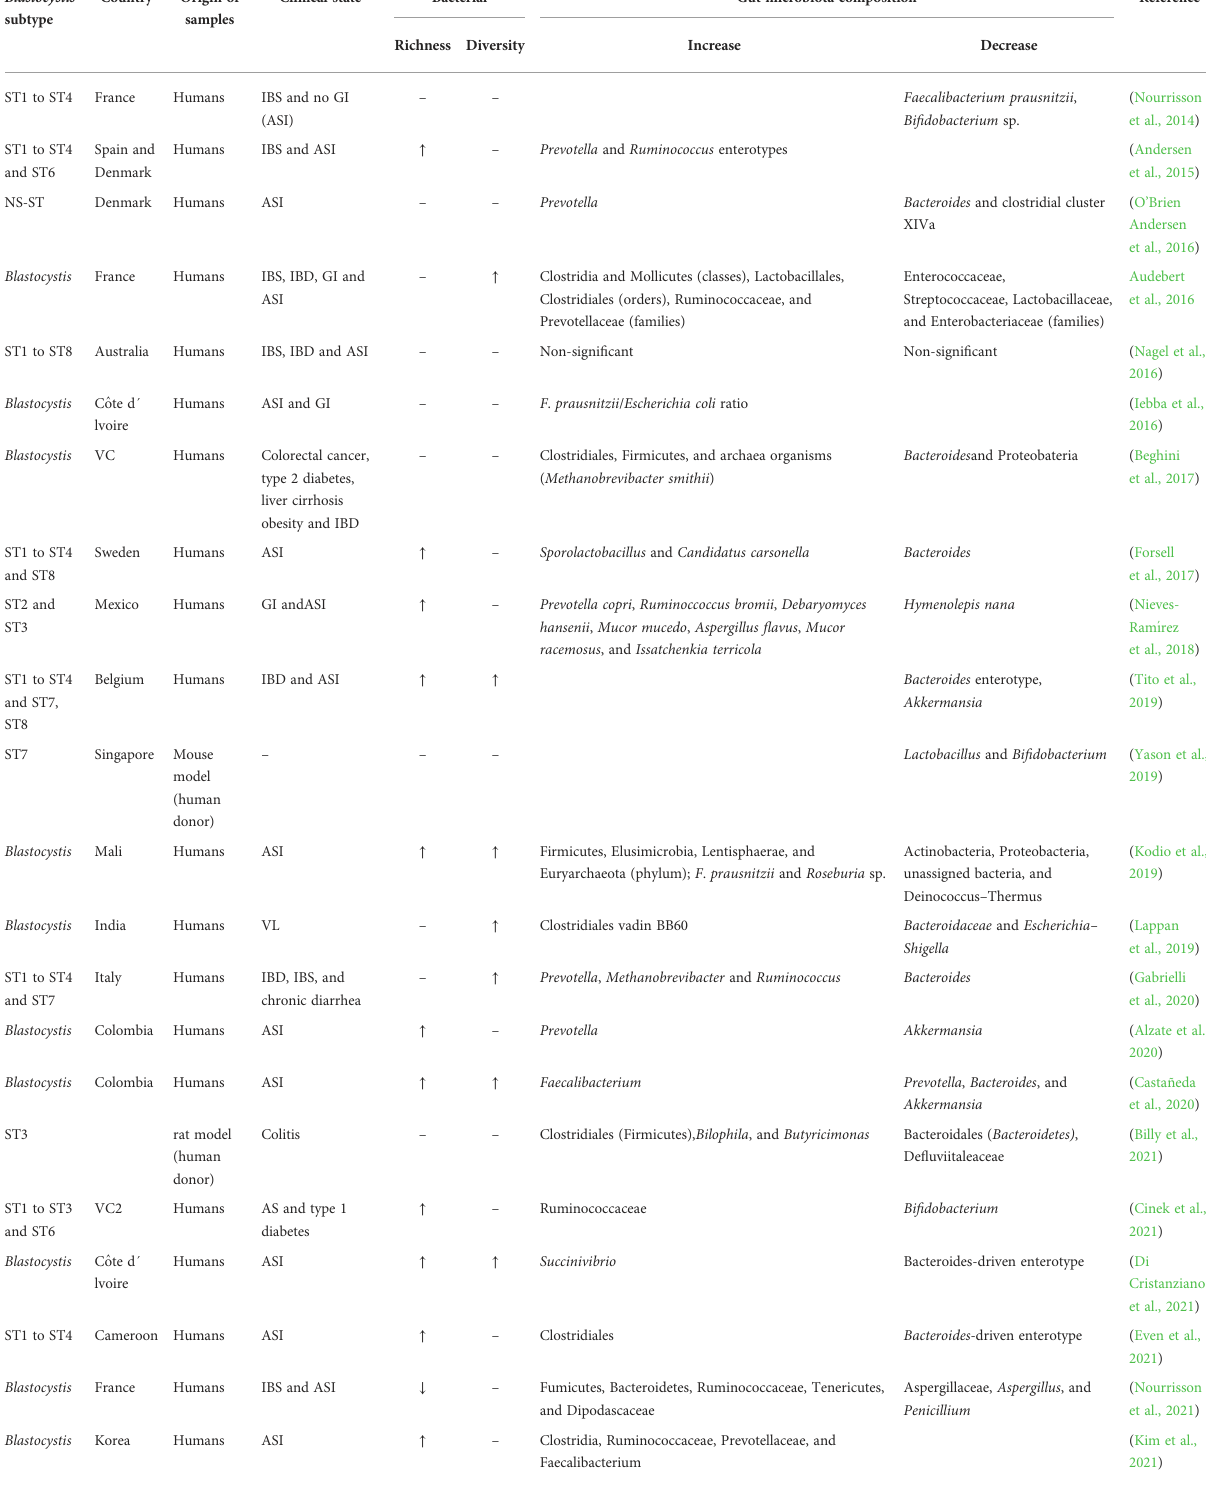
TABLE 1 Modi fi cations of Blastocystis spp. on the gut